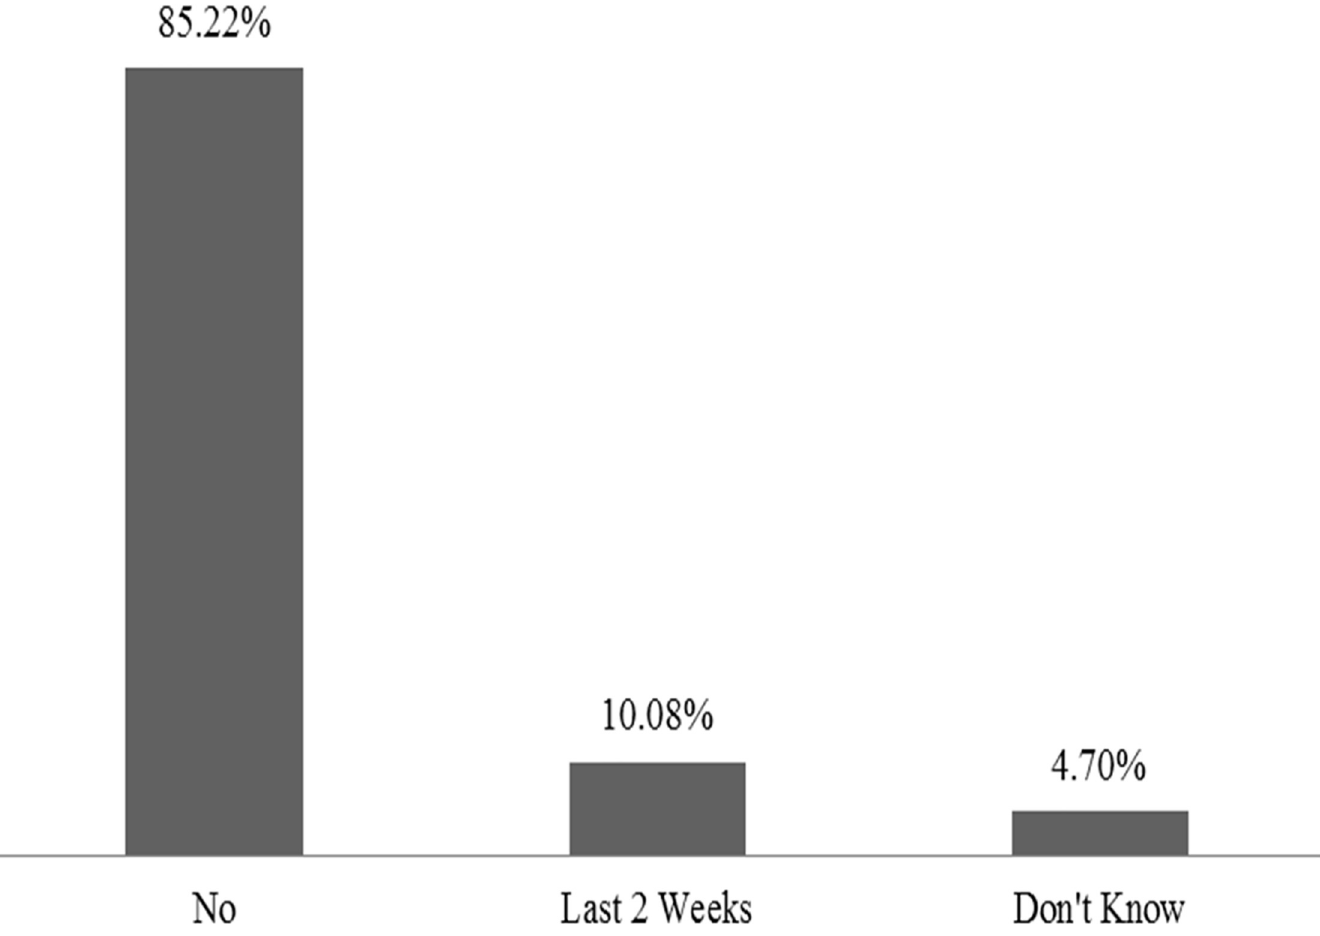
Fig 4. Percentage of under-5 children who had diarrhoea in the last two